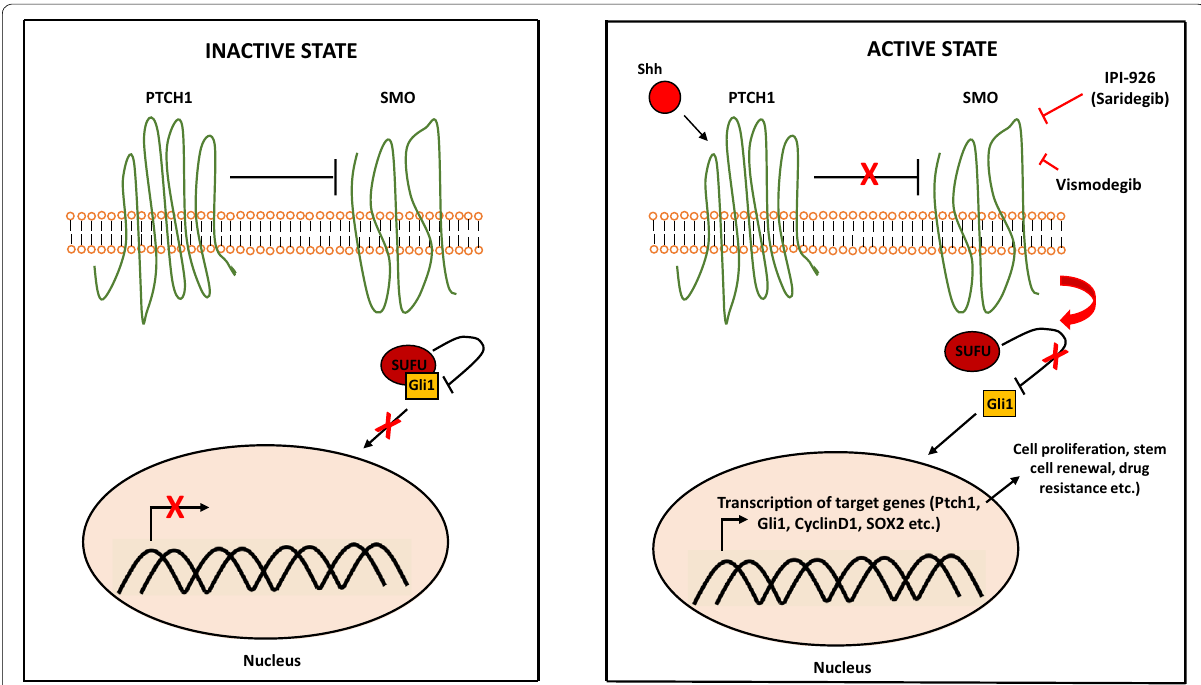
Fig. 2 Sonic hedgehog signaling pathway. In the absence of sonic hedgehog ligand (Shh), the surface receptor Patched1 (PTCH1) inhibits Smoothened (SMO), resulting in sequestration of Gli1 in the cytosol by Suppressor of fused (SUFU). Binding of Shh to PTCH1 abolishes constitutive inhibition of SMO by PTCH1, leading to liberation of Gli1 from SUFU. Released Gli1, then, translocates to the nucleus, where it promotes gene expression. Sonic Hedgehog inhibitors IPI-926 (Saridegib) and Vismodegib block SMO